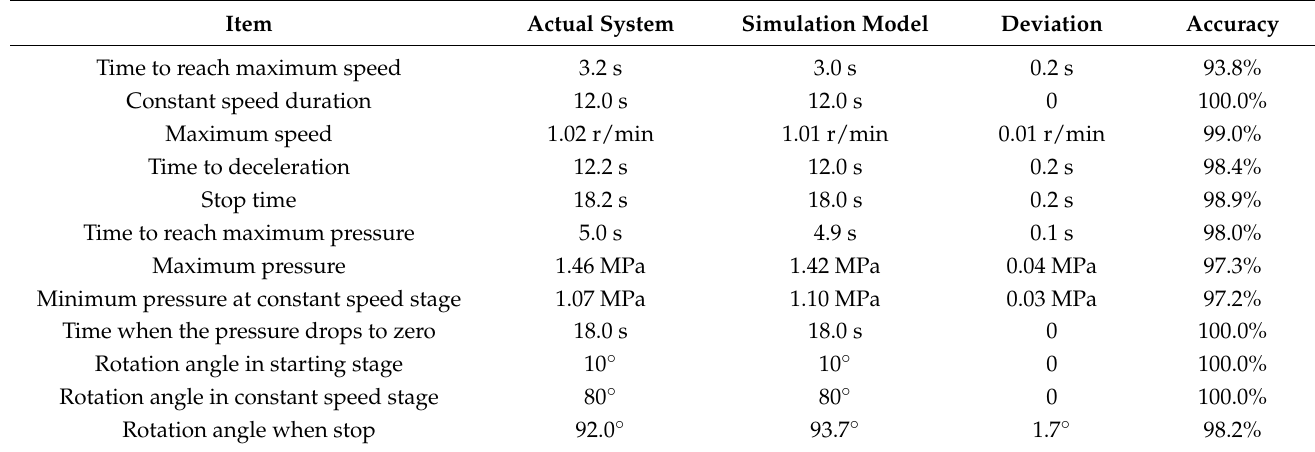
Table 3. Comparison of simulation and the actual system.